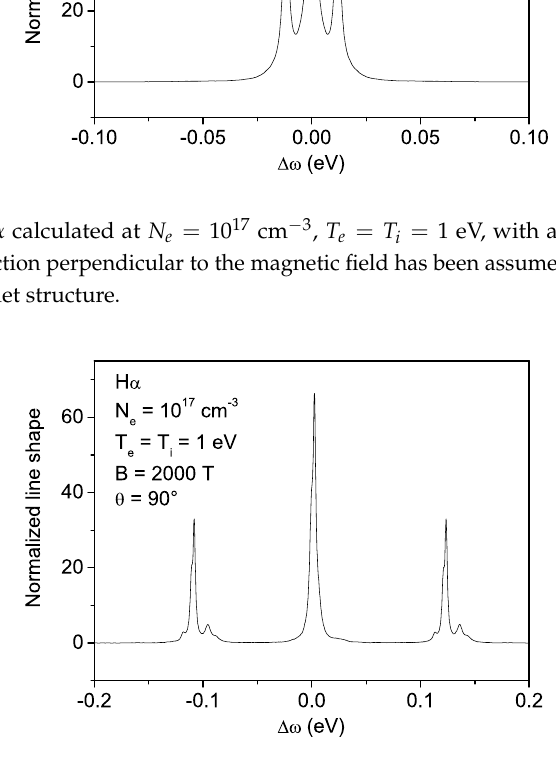
Figure 2. Some white dwarfs can have a magnetic field strong enough so that the quadratic Zeeman effect becomes significant. The spectrum becomes asymmetric and presents more